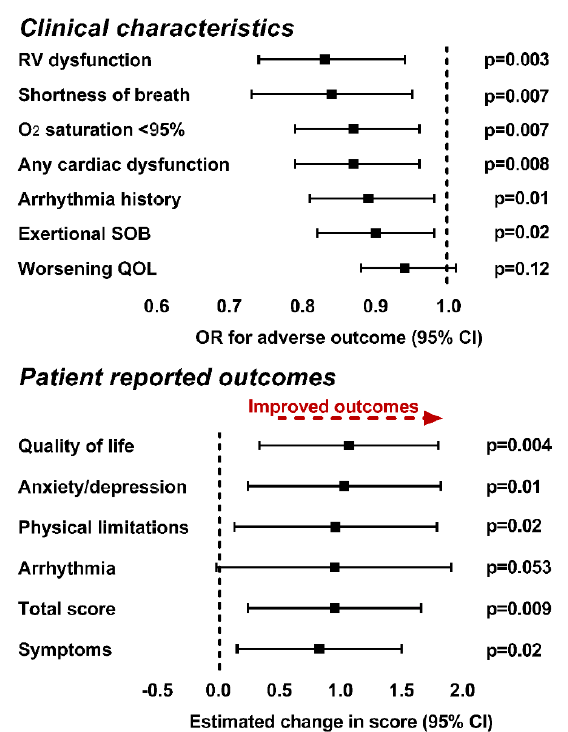
Figure 3. Association between patient score on PC4, clinical characteristics (top graph) and patient reported outcomes (bottom graph) in multivariable regression models. We found that higher plasma concentrations of the metabolites in PC4 were associated with both a decreased probability of adverse clinical characteristics and improved patient reported health status in all domains other than arrhythmia. Models for clinical outcomes (other than worsening quality of life) are adjusted for clinical covariates. Worsening quality of life is adjusted for age and TGA, anxiety/depression score, quality of life score, symptoms and total score are adjusted for the presence of non-cardiac diagnoses and the symptoms score is further adjusted for the sex of the participant. Abbreviations: